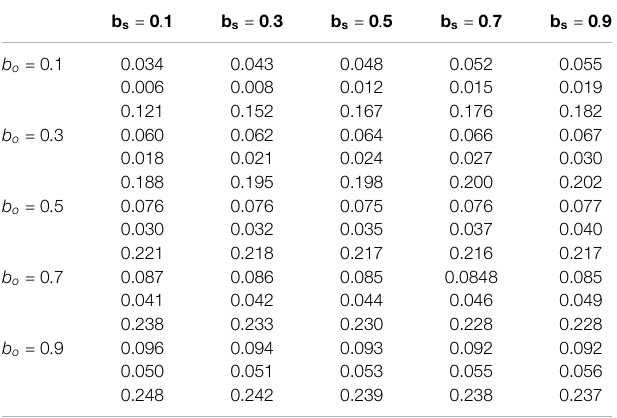
TABLE 1 | Threshold of θ given a (cid:1) 1 and c (cid:1) 0 . 1.